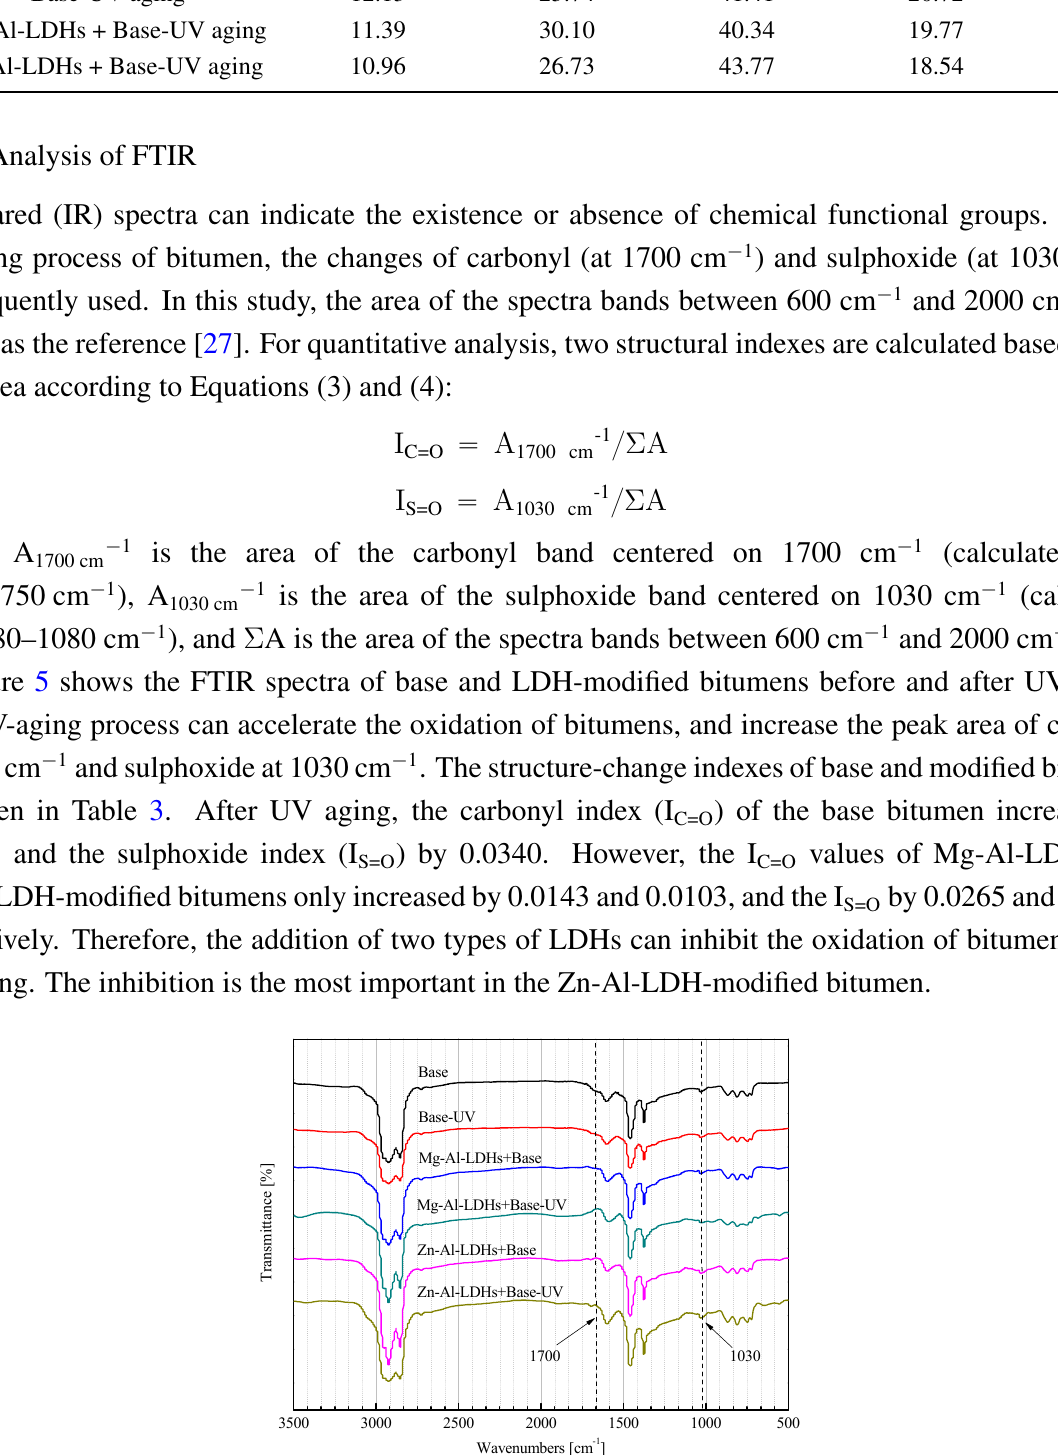
Figure 5. FTIR spectra of base and LDH-modified bitumens before and after UV aging. Table 3. Structure-change indexes of base and modified bitumens before and after UV aging.